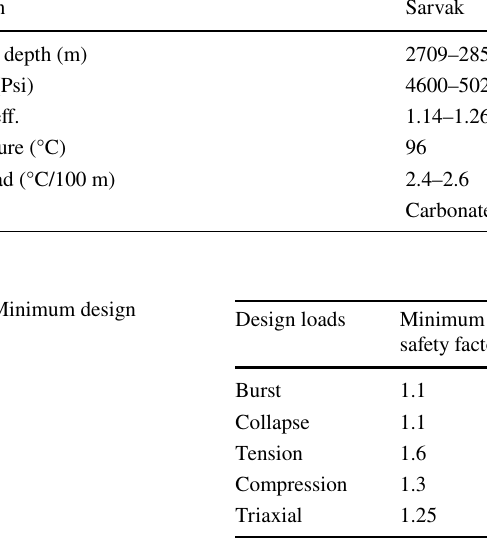
Fig. 2 Tested pressure (left) and tested temperature (right) in offset wells Table 2 Sarvak reservoir information Formation